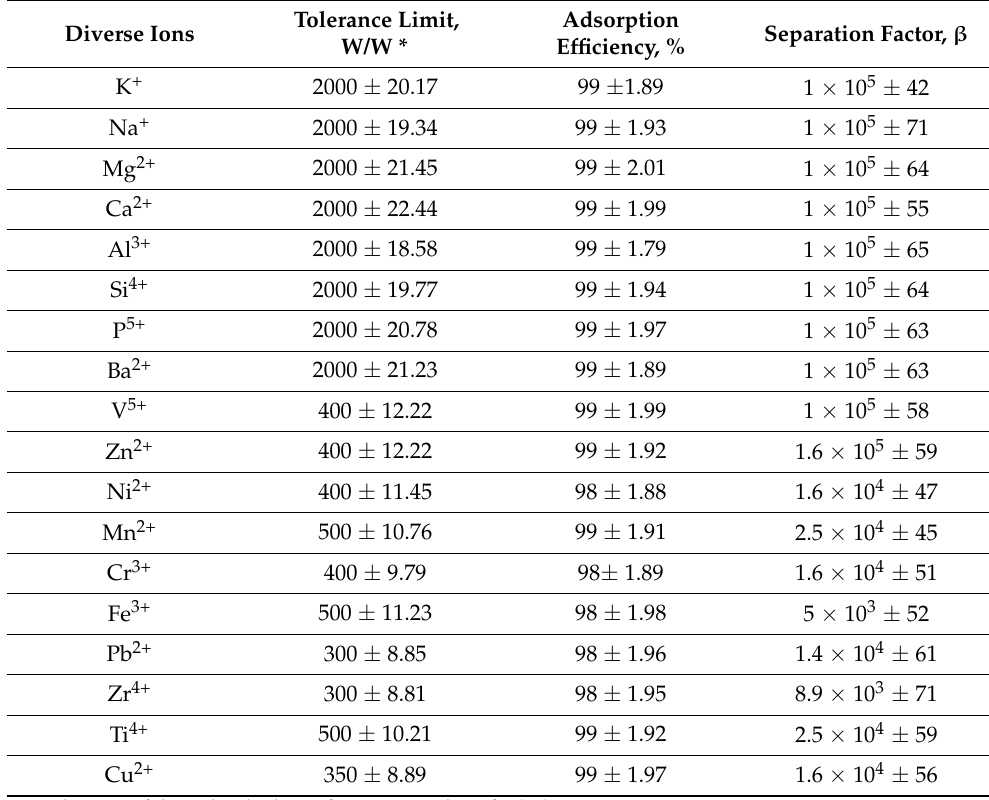
Table 6. Diverse ions effect on U(VI) sorption efficiency using SiO 2 /CS. Tolerance Limit, Adsorption Separation Factor, β Diverse Ions W/W * Efficiency, % K + 2000 ±